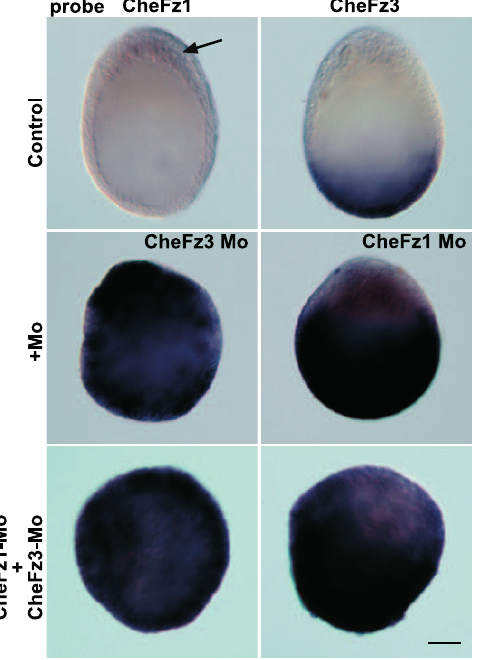
Figure 5. Reciprocal Regulation of CheFz1 and CheFz3 Representative in situ hybridisation images obtained with CheFz1 and CheFz3 probes on control and morpholino-injected embryos. The arrow points to the weak oral CheFz1 expression domain in controls at this stage. Each morpholino causes massive up-regulation of the other RNA, albeit with vestiges of an oral–aboral gradient still discernable. A mixture of both morpholinos caused simultaneous up-regulation of both RNAs.